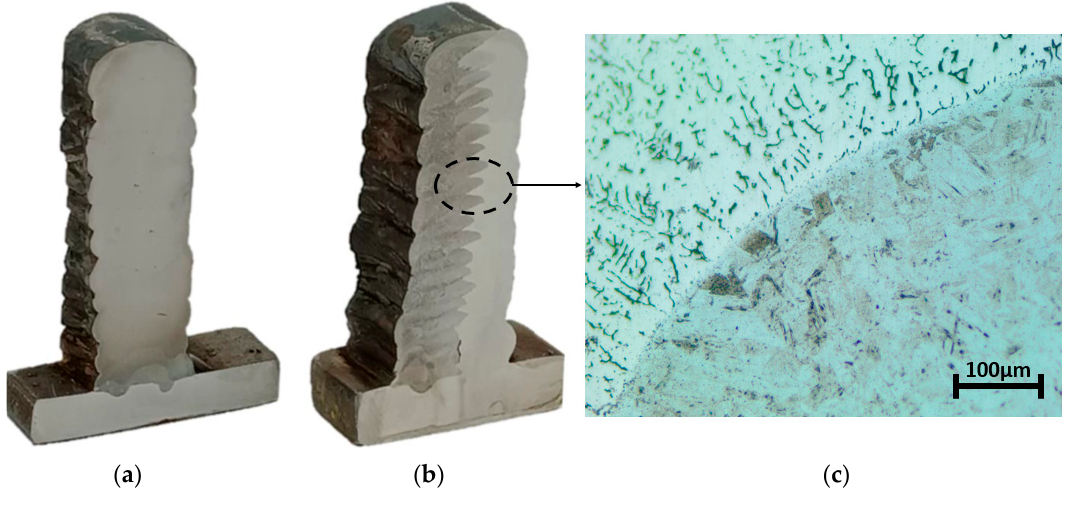
Figure 2. Representative sections of ( a ) single ‐ material and ( b ) multi ‐ material deposition; ( c ) intersection in multi ‐ material. Table 2. WAAM deposition parameters and calculated heat